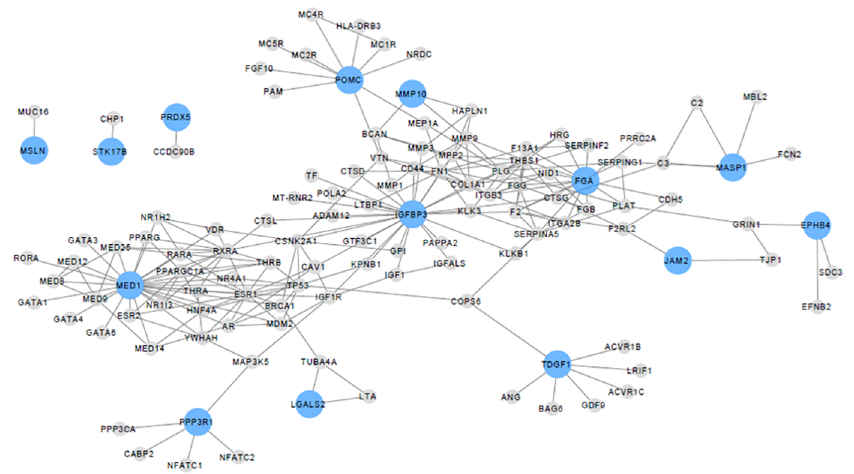
Fig 4. Network displaying proteins significantly associated with the disposition index and their direct interactions. The nodes represent proteins and the edges represent protein-protein interactions. Proteins significantly related with the disposition index are in blue (p (cid:20) 0.01) and grey nodes are their direct interactions. 13/17 proteins significantly associated with the disposition index have direct interactions.